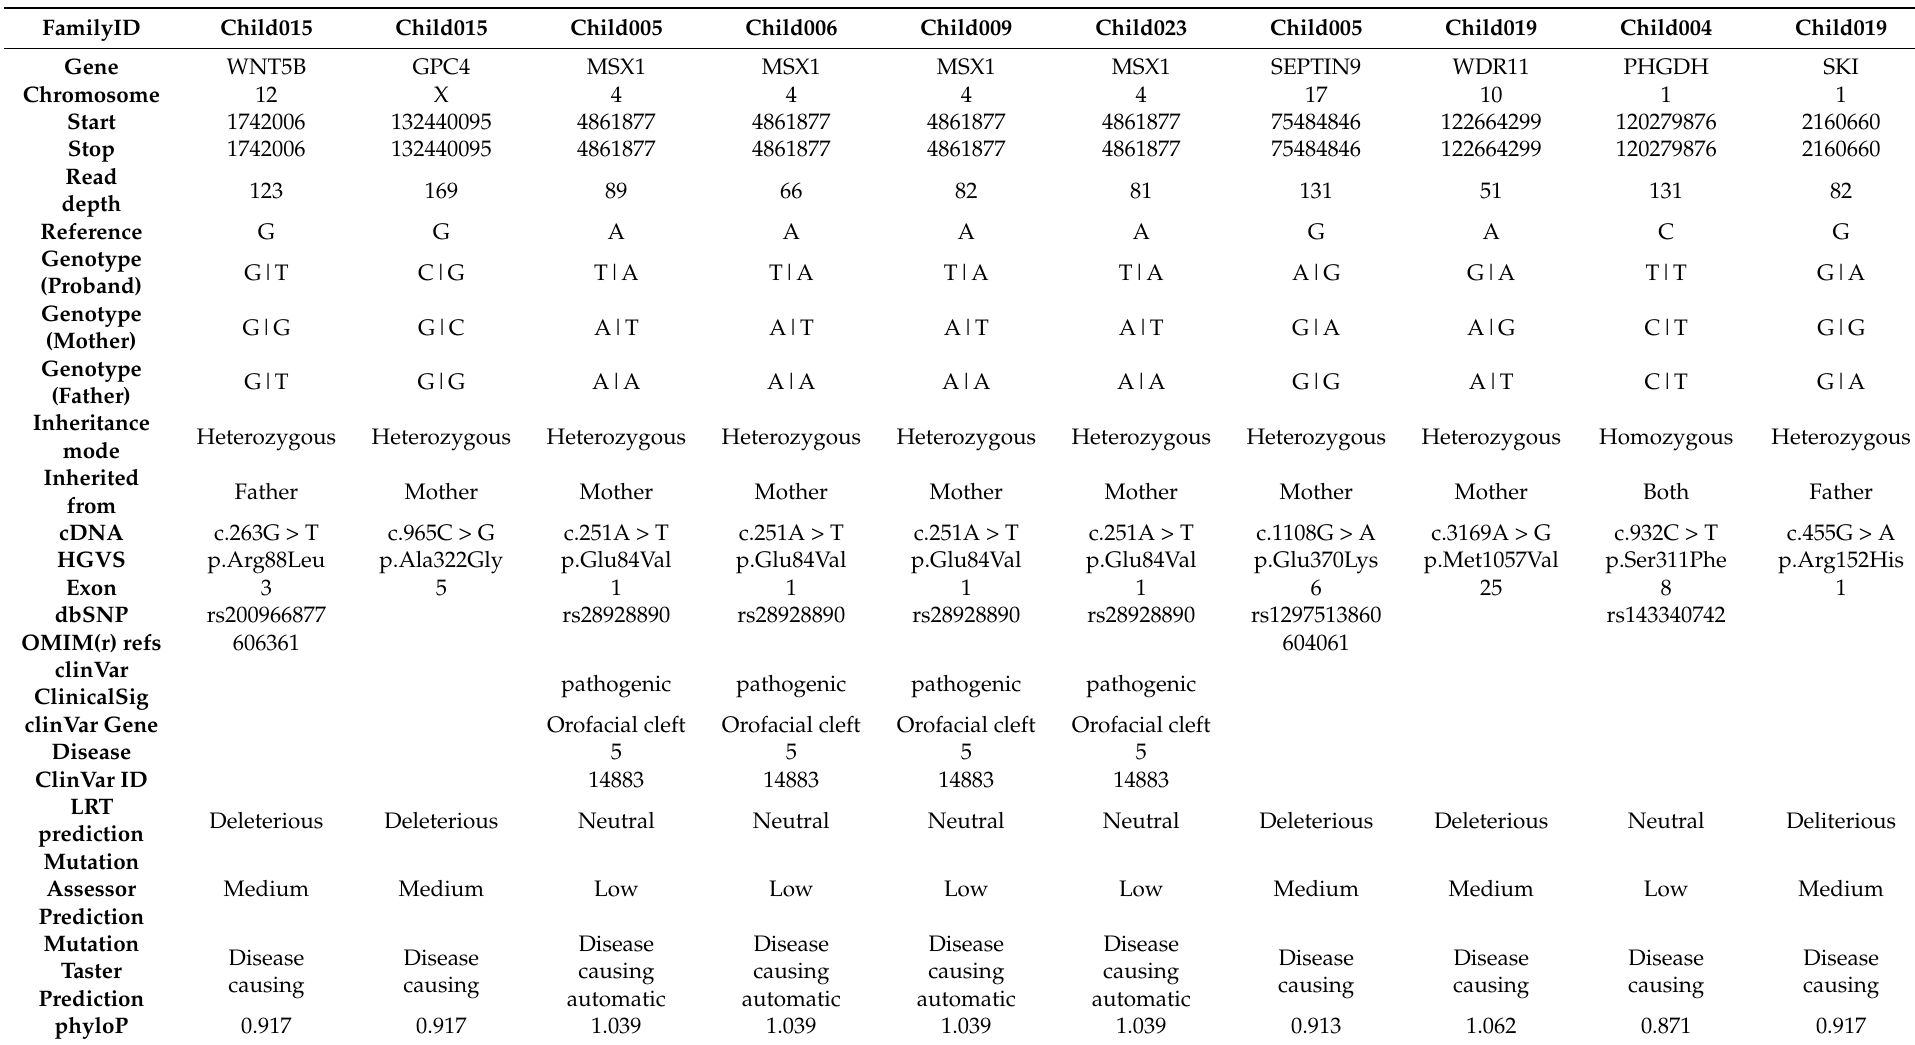
Table 2. Variant description found in 26 Malagasy children with